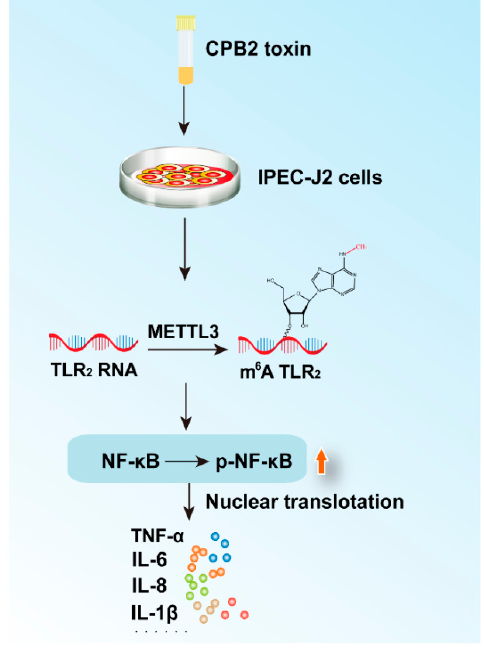
Figure 9. A schematic depiction showing METTL3 controlling inflammatory responses in CPB2-exposed IPEC-J2 cells through the TLR2/NF- κ B pathway. TLR2 was activated by METTL3 through m6A methylation, and TLR2 in turn activated NF- κ B, which was then phosphorylated into the nucleus, promoting the release of inflammatory cytokines. Red arrows indicate elevated levels of NF- κ B protein